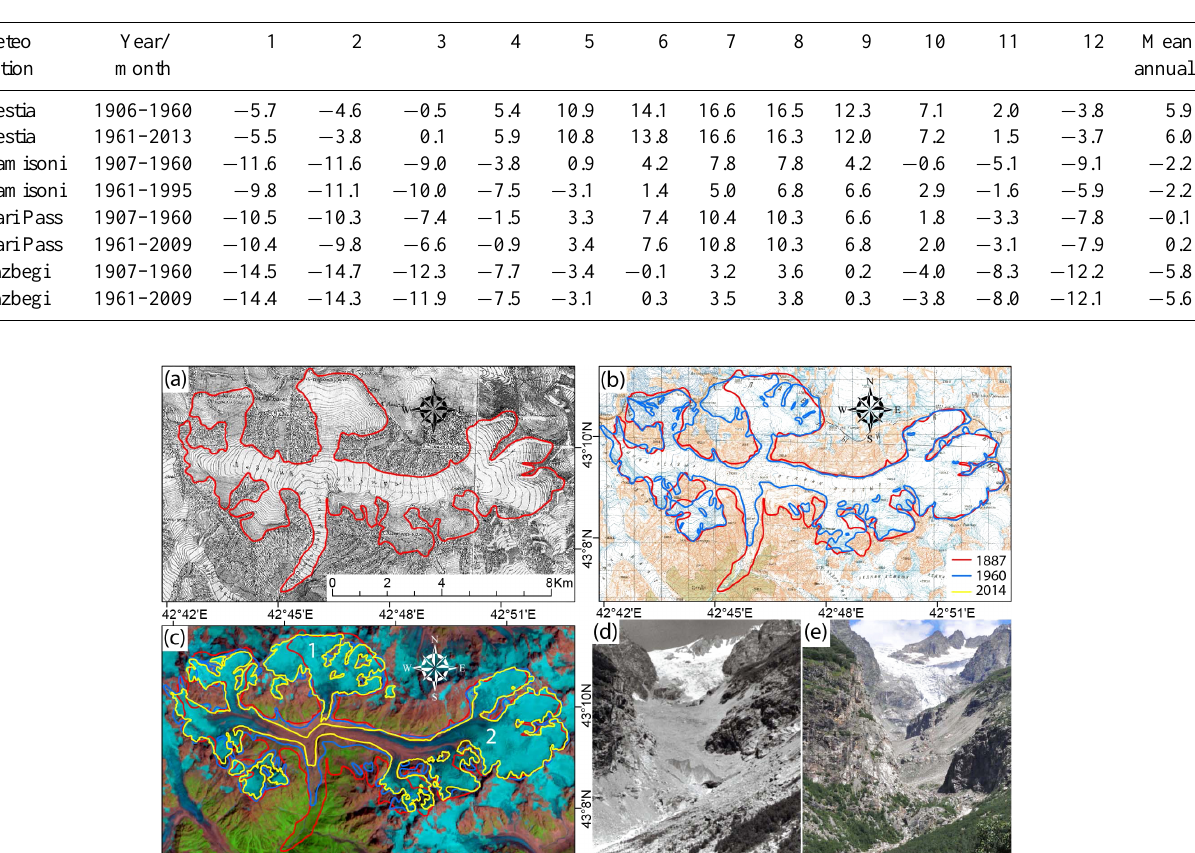
Table 3. Mean monthly air temperatures ( ◦ C) at the Mestia, Mamisoni, Jvari Pass and Kazbegi meteorological stations in the years of